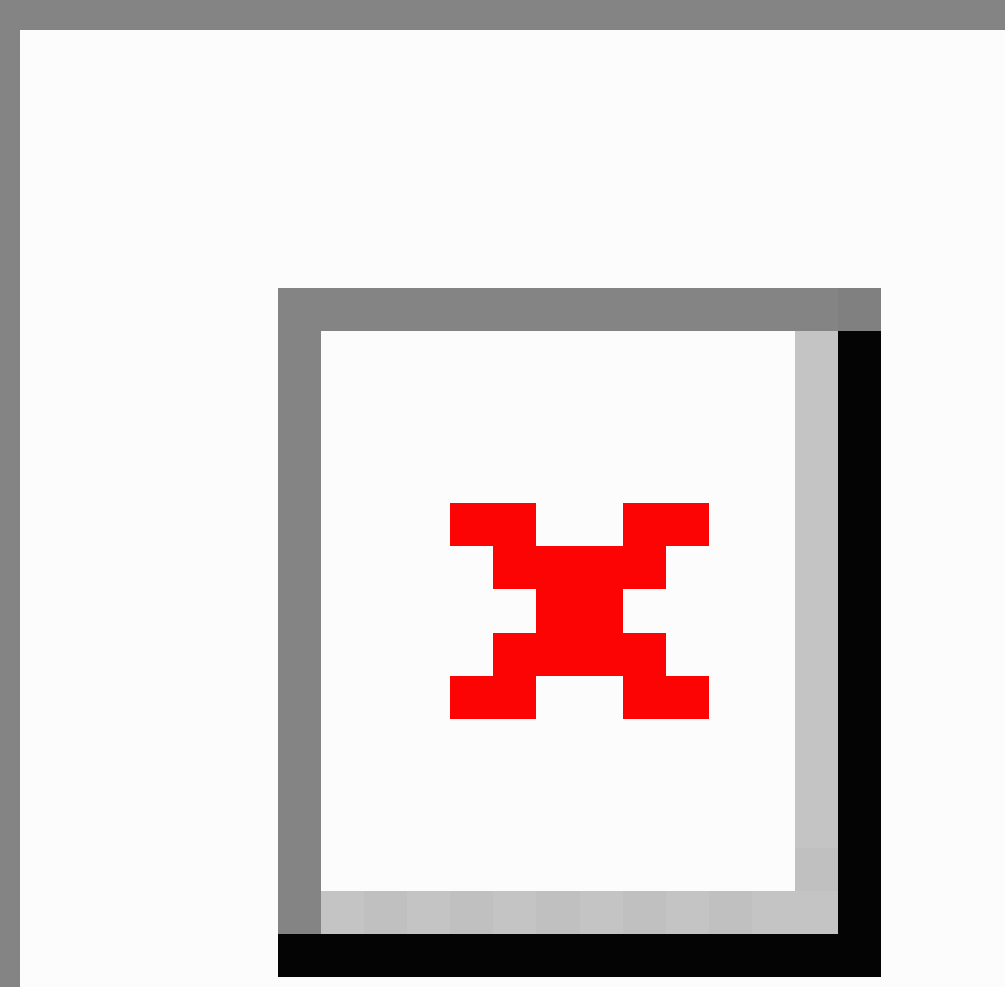
Figure 3. Feature of 3 functionalities on smartphone questionnaire: (a) dropdown choice, (b) picture capturing, and (c) voiced